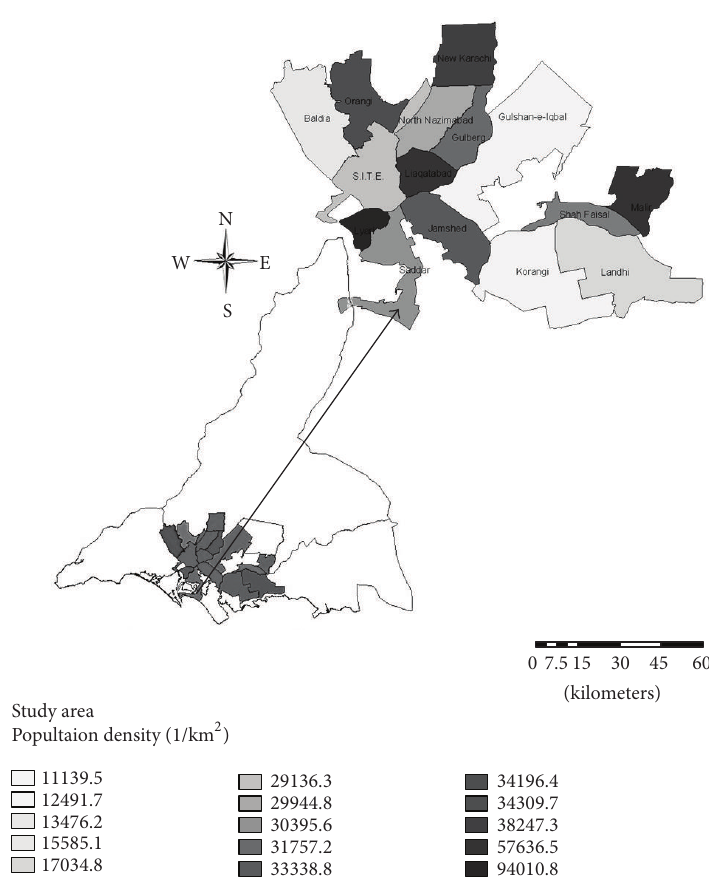
94010.8Popultaion density (1/km 2 )